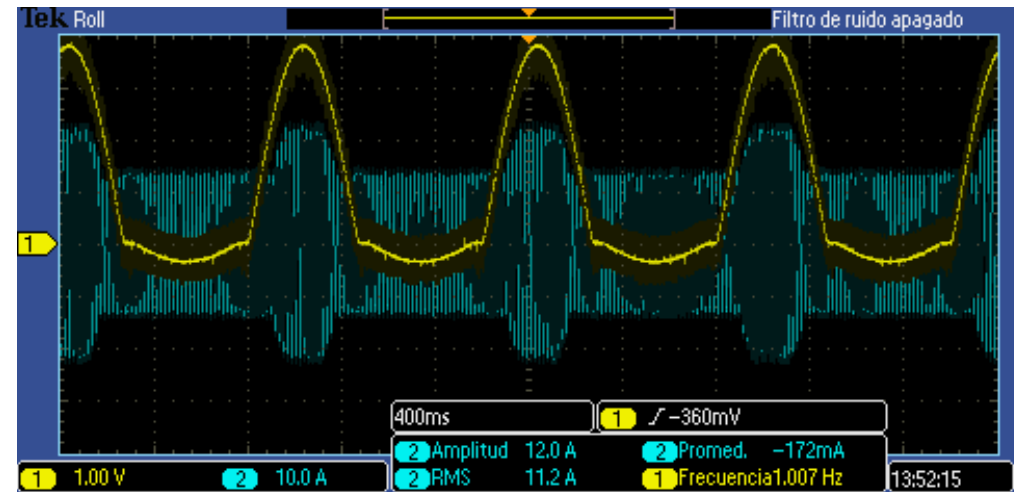
Figure 20. Motor current under control. Reference signal frequency: 1 Hz. Electronics 2018 , 7 , x FOR PEER REVIEW